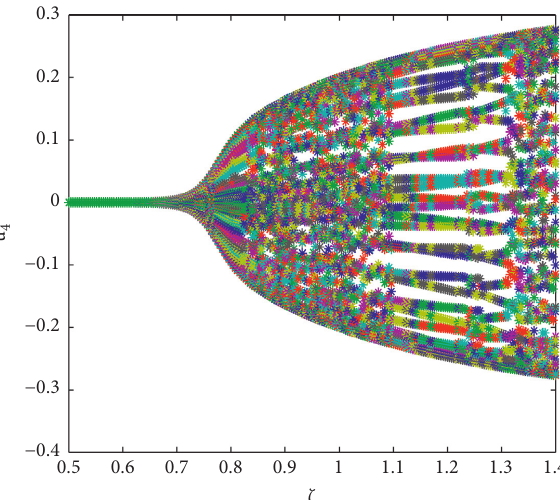
Figure 4: Bifurcation figure of neural network model (46): ζ - u